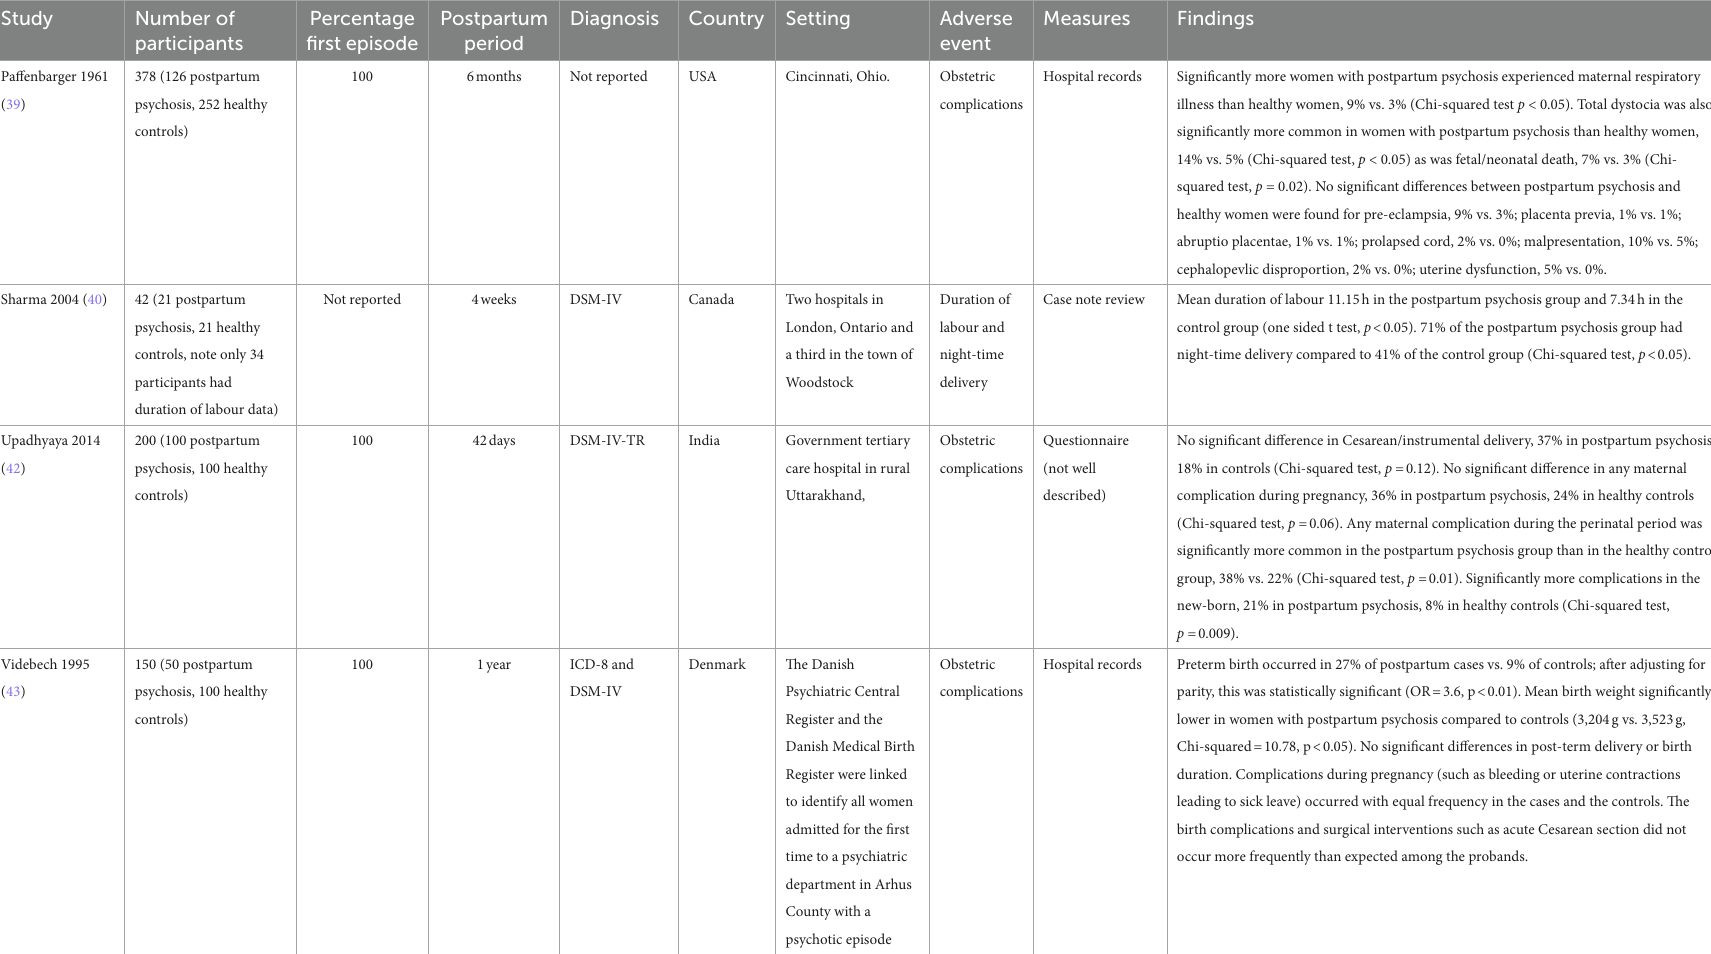
Significantly more women with postpartum psychosis experienced maternal respiratory illness than healthy women, 9% vs. 3% (Chi-squared test p < 0.05). Total dystocia was also significantly more common in women with postpartum psychosis than healthy women, 14% vs. 5% (Chi-squared test, p < 0.05) as was fetal/neonatal death, 7% vs. 3% (Chi- squared test, p = 0.02). No significant differences between postpartum psychosis and healthy women were found for pre-eclampsia, 9% vs. 3%; placenta previa, 1% vs. 1%; abruptio placentae, 1% vs. 1%; prolapsed cord, 2% vs. 0%; malpresentation, 10% vs. 5%; cephalopevlic disproportion, 2% vs. 0%; uterine dysfunction, 5% vs. 0%. Case note review Mean duration of labour 11.15 h in the postpartum psychosis group and 7.34 h in the control group (one sided t test, p < 0.05). 71% of the postpartum psychosis group had night-time delivery compared to 41% of the control group (Chi-squared test, p < 0.05).